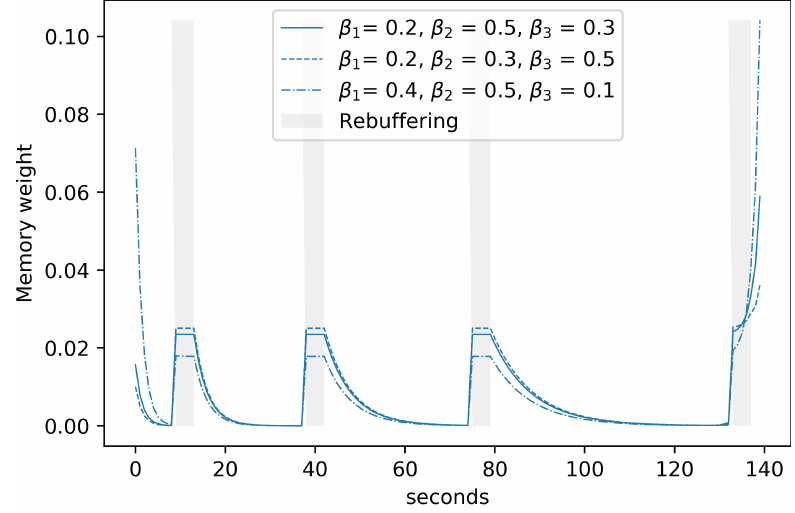
Figure 5. An example of the memory weight in a session under different values of parameters β 1 , β 2 , and β 3